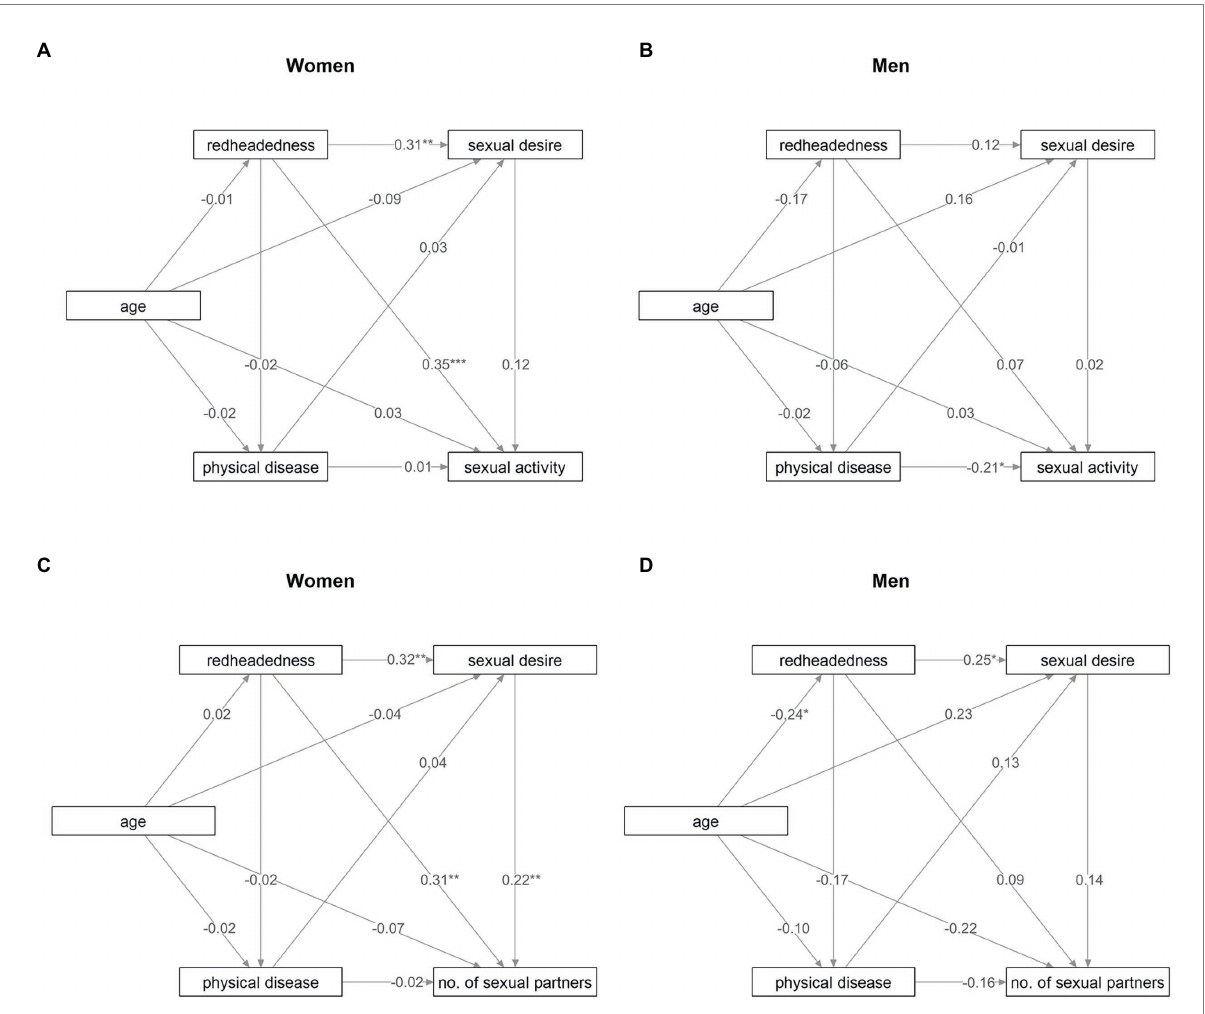
FIGURE 2 Direct and indirect effects of redheadedness on sexual activity and the number of sexual partners of the preferred sex in women and men. The figure visualizes the results of path analyses. Numbers at arrows show standardized parameter estimates. Associations with p values under 0.05 are marked by “*”, those with p values under 0.01 are marked by “**”, and those with p values under 0.001 are marked by “***”. (A) Relations between redheadedness and sexual activity in women. (B) Relations between redheadedness and sexual activity in men. (C) Relations between redheadedness and the number of sexual partners of the preferred sex in women. (D) Relations between redheadedness and the number of sexual partners of the preferred sex in